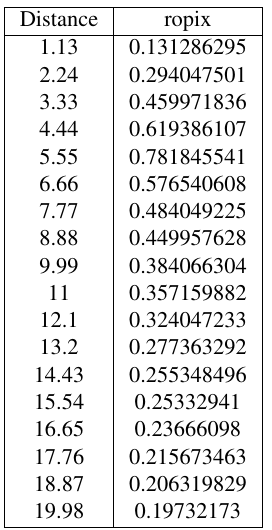
Table 5. Experiment Results of F e